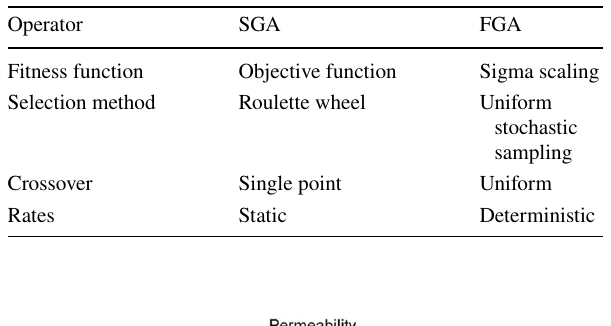
Table 2 SGA and FGA operators